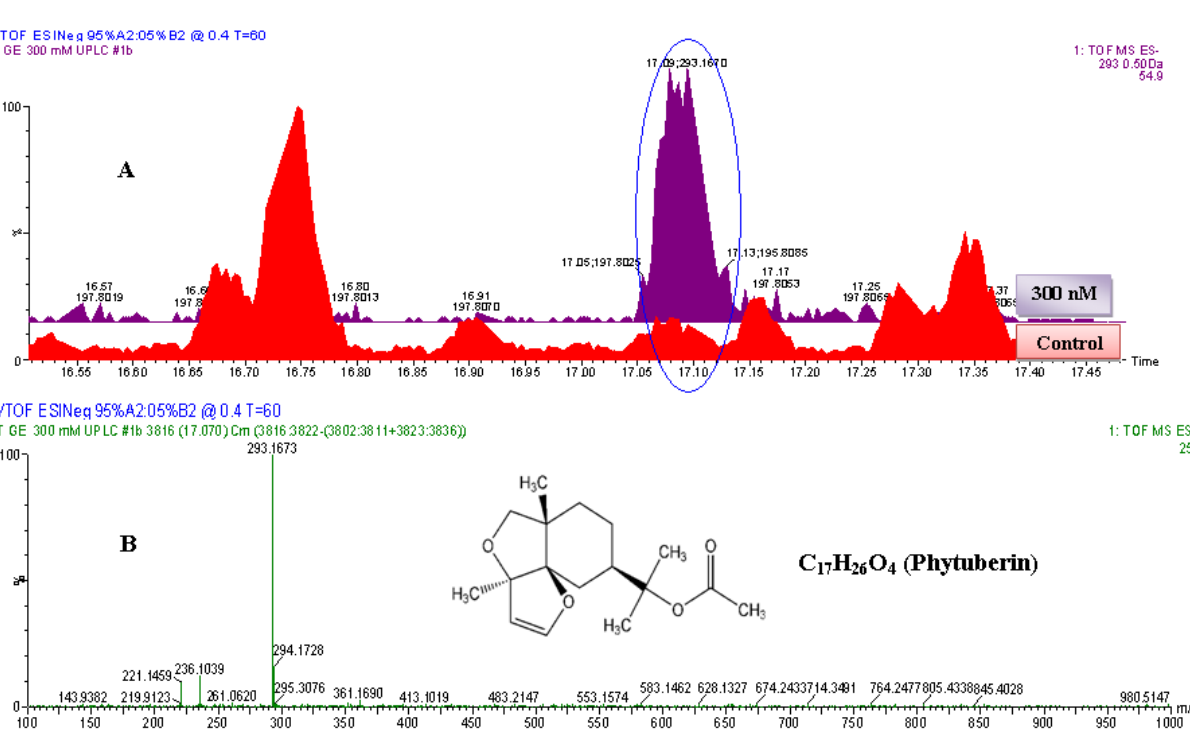
H O , with 17 25 4